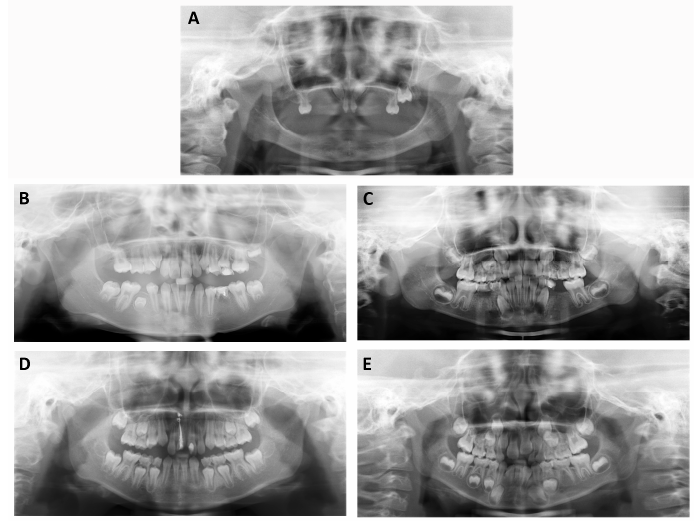
Figure 1. Panoramic radiograph of the probands of X-linked hypohidrotic ectodermal dysplasia (XLHED) Family 2 ( A ); non-syndromic tooth agenesis (NSTA) Family 1 ( B ); NSTA Family 2 ( C ); NSTA